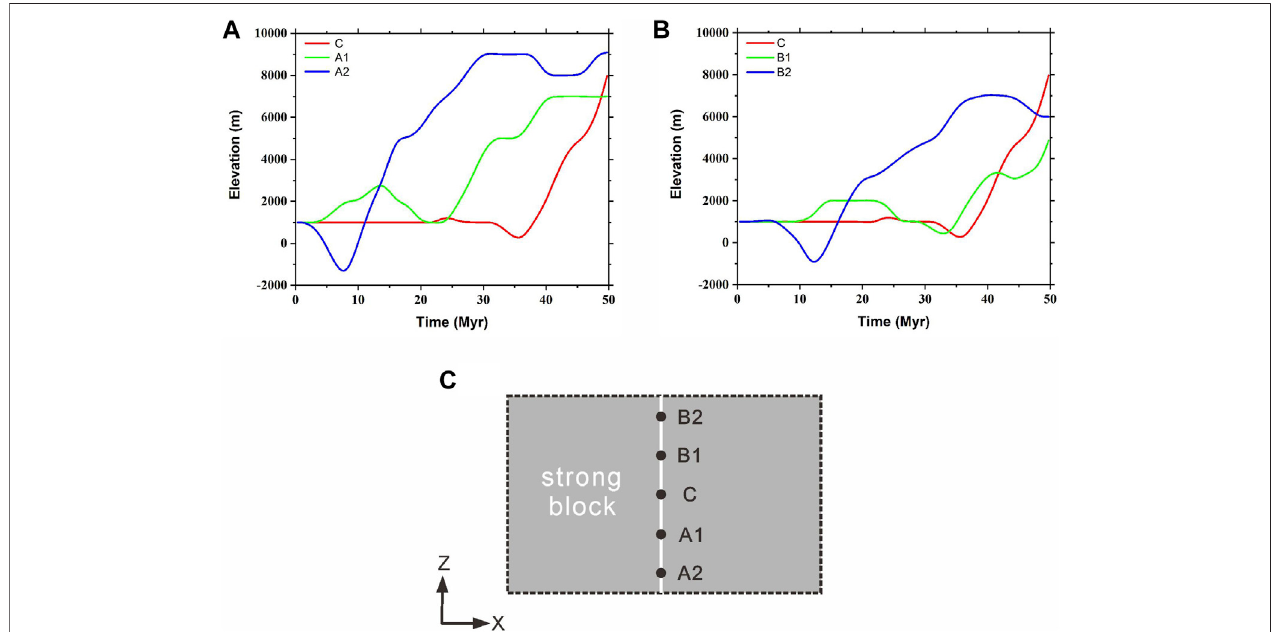
FIGURE5| Plotsofelevationversustimefordifferentpointswithinthestrongbasin.In (A) and (B) ,theredcurvesrepresent theuplifthistoryatthecenterpoint (C) . Thebluecurvesrepresenttheuplifthistoryofthemarginalpoints(A2,B2).ThegreencurvesrepresenttheuplifthistoryatpointsA1andB1 (C) PositionsofpointsA1,A2, B1, B2, and C in the interior of the strong